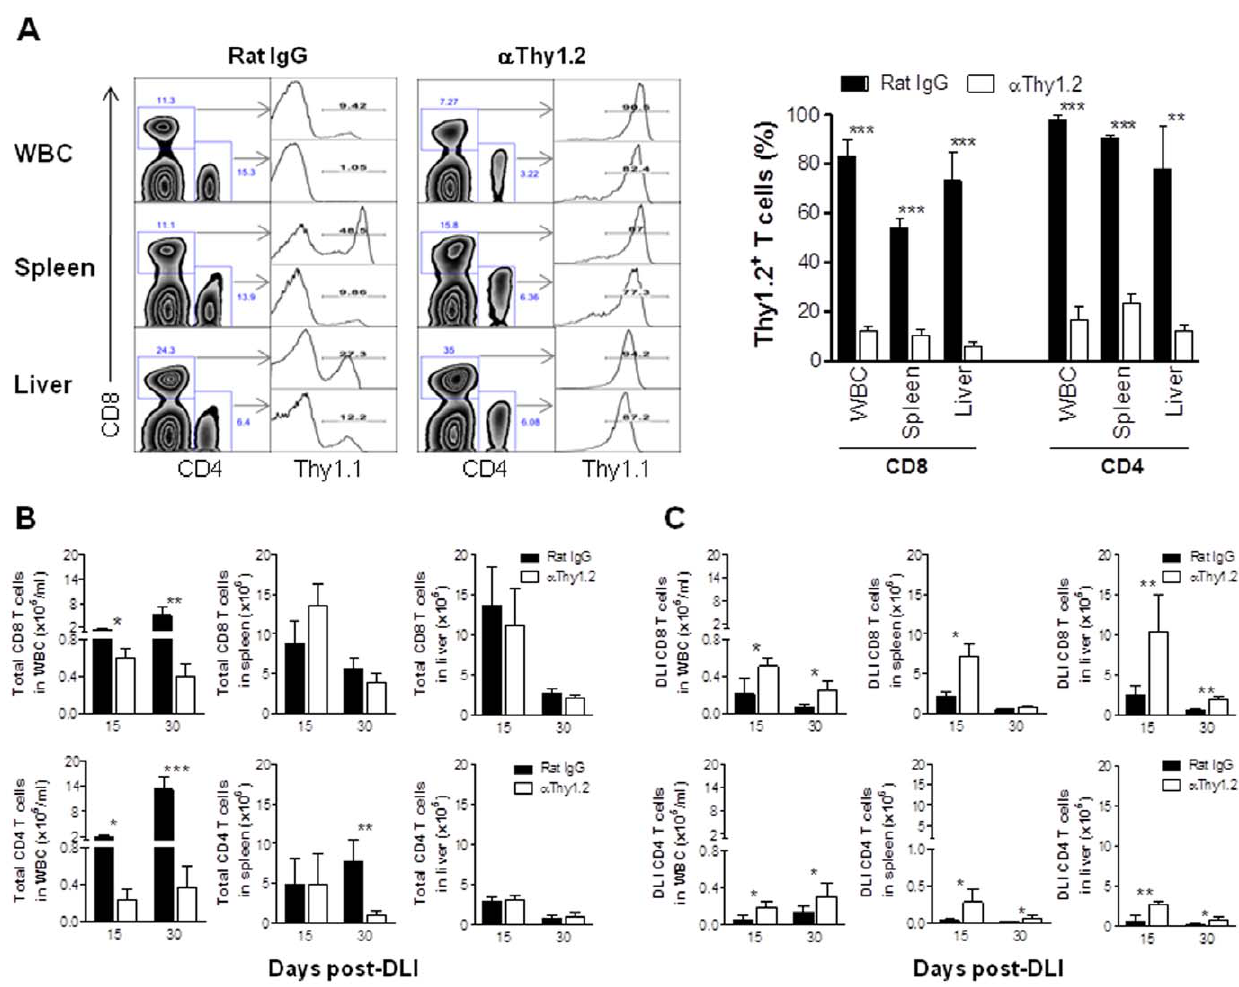
Figure 5. Donor DLI-derived T cell expansion following the depletion of donor BM-derived T cells. MC preparation and DLI administration were performed as detailed in the legend to Figure 4, and treated with anti-Thy1.2 or Rat IgG starting at day 10 post-DLI. MCs were sacrificed 5 (n=3 per group) and 20 (Rat IgG, n=3; a Thy1.2, n=4) days after antibody treatment (i.e., 15 and 30 days after DLI, respectively), and the levels of Th1.1 + and Thy1.2 + T cells in various tissues were determined by flow cytometry using anti-Thy1.1 mAb. (A) Representative staining profiles (Left) and levels (mean 6 SEM) of Thy1.2 + (i.e., cells stained negative for Thy1.1) T cells in various tissues at day 5 post-antibody treatment (15 day after DLI). (B,C) Numbers (mean 6 SEM) of total (B) and DLI-derived Thy1.1 + (C) T cells (CD8 and CD4 T cells are shown at the top and bottom panels, respectively) in WBC, spleen and liver at the indicated time points. *, p , 0.05; **, p , 0.01; ***, p , 0.005.